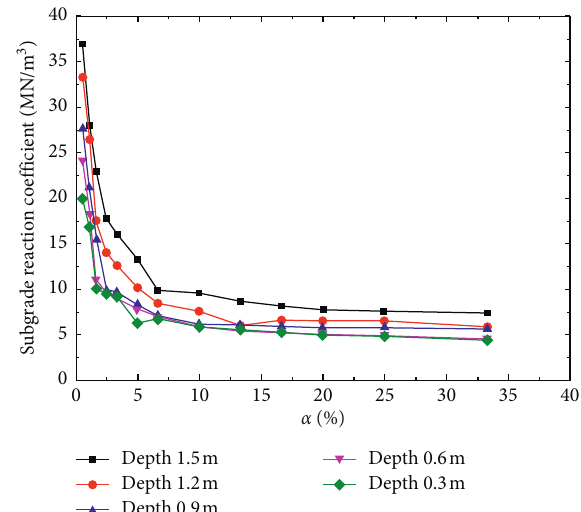
Figure 16: Horizontal normal subgrade reaction coefficients versus rotation